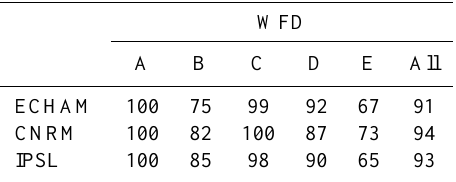
Table 2. Similarity index (SI) between the reference model with meteorological forcing from the WATCH Forcing Data and models with meteorological forcing from three GCMs (ECHAM, CNRM, IPSL) for the control period (1971–2000). SI is given for all major climates, Equatorial (A), Arid (B), Warm temperate (C), Snow (D) and Polar climates (E), and for averaged over all climates. WFD